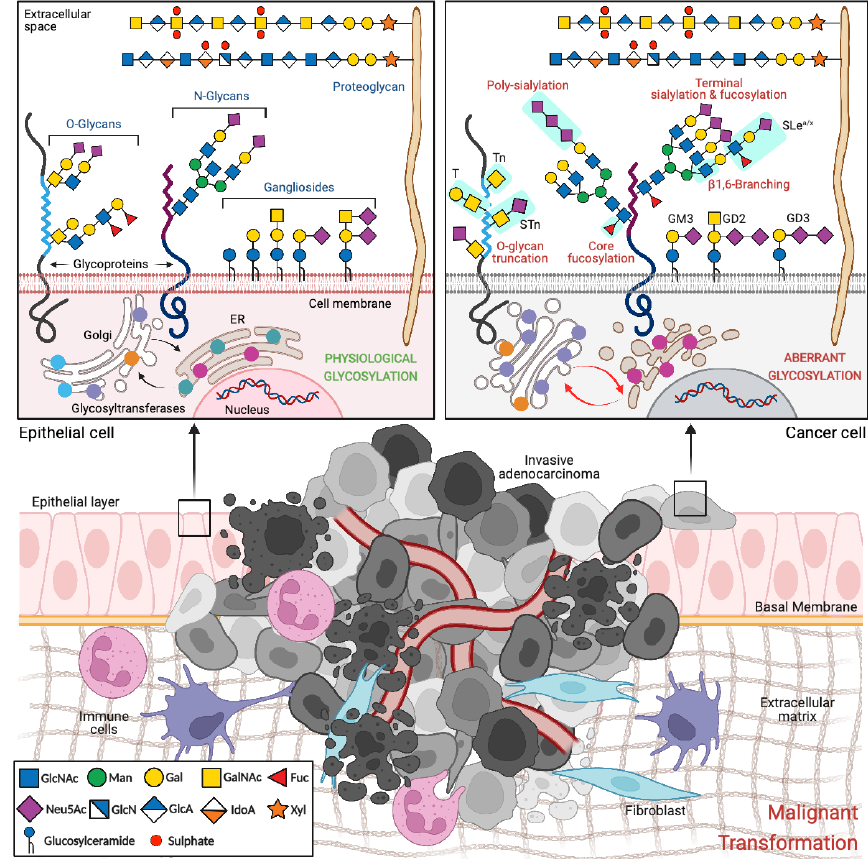
Figure 1. Glycosylation alterations during malignant transformation. Abbreviations: ER— endoplasmic reticulum; Fuc—fucose; Gal—galactose; GlcN—glucosamine; GlcA—glucuronic acid; GlcNAc—N-acetylglucosamine; GalNAc—N-acetylgalactosamine; IdoA—iduronic acid; Man— mannose; Neu5Ac—N-acetylneuraminic acid; STn—sialyl Tn; SLe a/x —sialyl Lewis a/x; T—Thomsen– Friedenreich antigen;